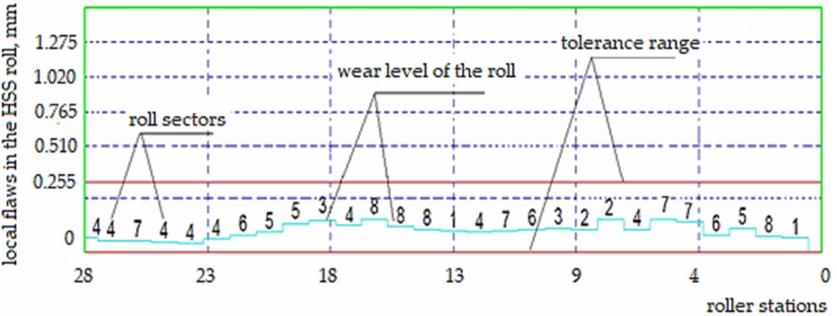
Figure 7. Graph-level defects generated on the basis of faults map of type HSS. Source: own, based on